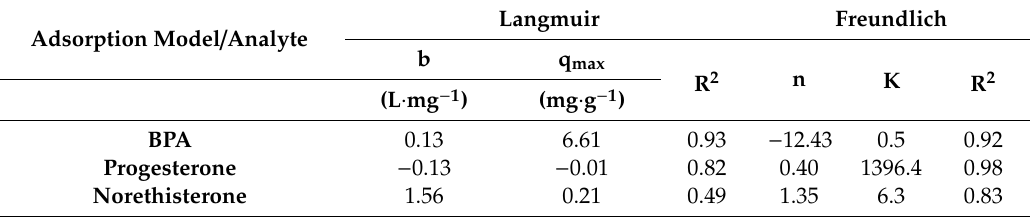
Table 1. Isotherm parameters for adsorption of BPA, progesterone and norethisterone by the GO–PEI–FeNPs composite. Adsorption Model /